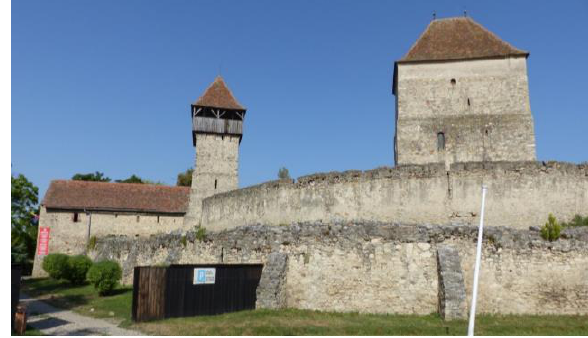
Figure 5. Defensive system of Câlnic Fortified Church.